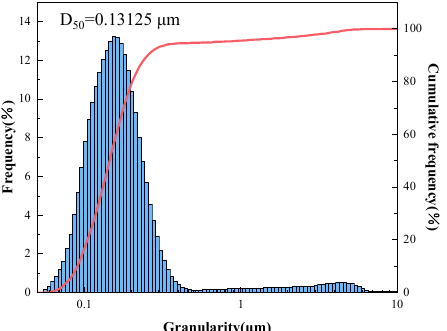
Figure 1. Particle size distribution of nano blocker AMPS/AM.